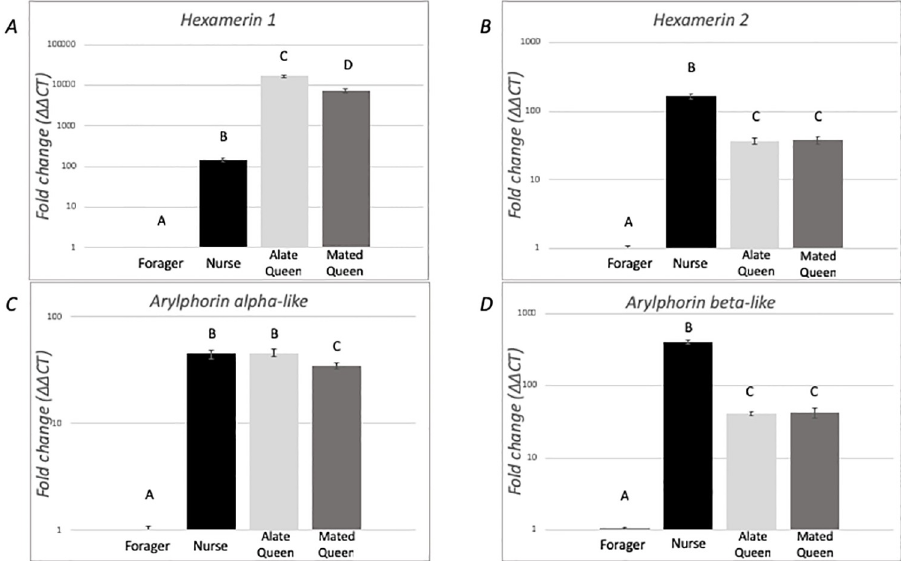
Fig 2. Expression analysis of hexamerin transcripts among medium-sized foragers, medium-sized nurses, alate virgin queens, and dealate mated queens. Relative expression levels of (A) hexamerin 1 , (B) hexamerin 2 , (C) arylphorin subunit alpha-like , and (D) arylphorin subunit beta transcripts. Gene expression was quantified using RT- qPCR and analyzed using the ΔΔ Ct method. For each gene, mRNA expression level was normalized relative to rp18 . Bars represents mean ± SEM fold change relative to foragers ( n = 6). Different letters indicate significant differences in gene expression as determined by one-way ANOVA with Tukey’s post hoc analyses ( p < 0.05). The fold change in the Y-axis is in log-scale.